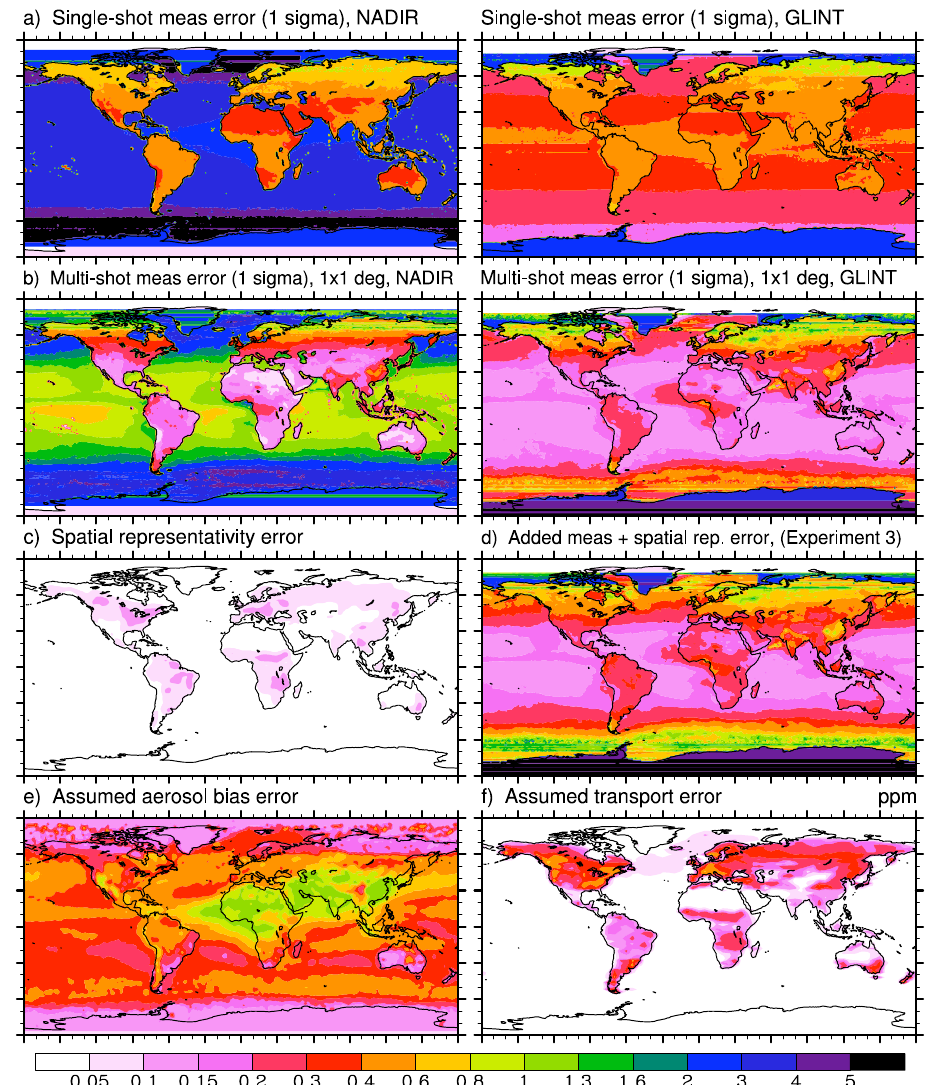
Fig. 6. (a) The single-sounding OCO X CO retrieval uncertainties σ 1shot computed in B¨osch et al., for both nadir (left) and glint (right) 2 viewing modes. (b) The effective multi-sounding OCO X CO measurement uncertainty σ eff , computed as σ eff = σ 1shot / 2 from Fig. 7a, (c) The assumed spatial representation error, extrapolated from Corbin et al. (2008). (d) The random measurement error added to the data (in place of σ eff in Fig. 6b) in Experiment 3, the mistuning experiment. The extra measurement uncertainty assumed to account for the impact of (e) aerosol biases and (f) transport